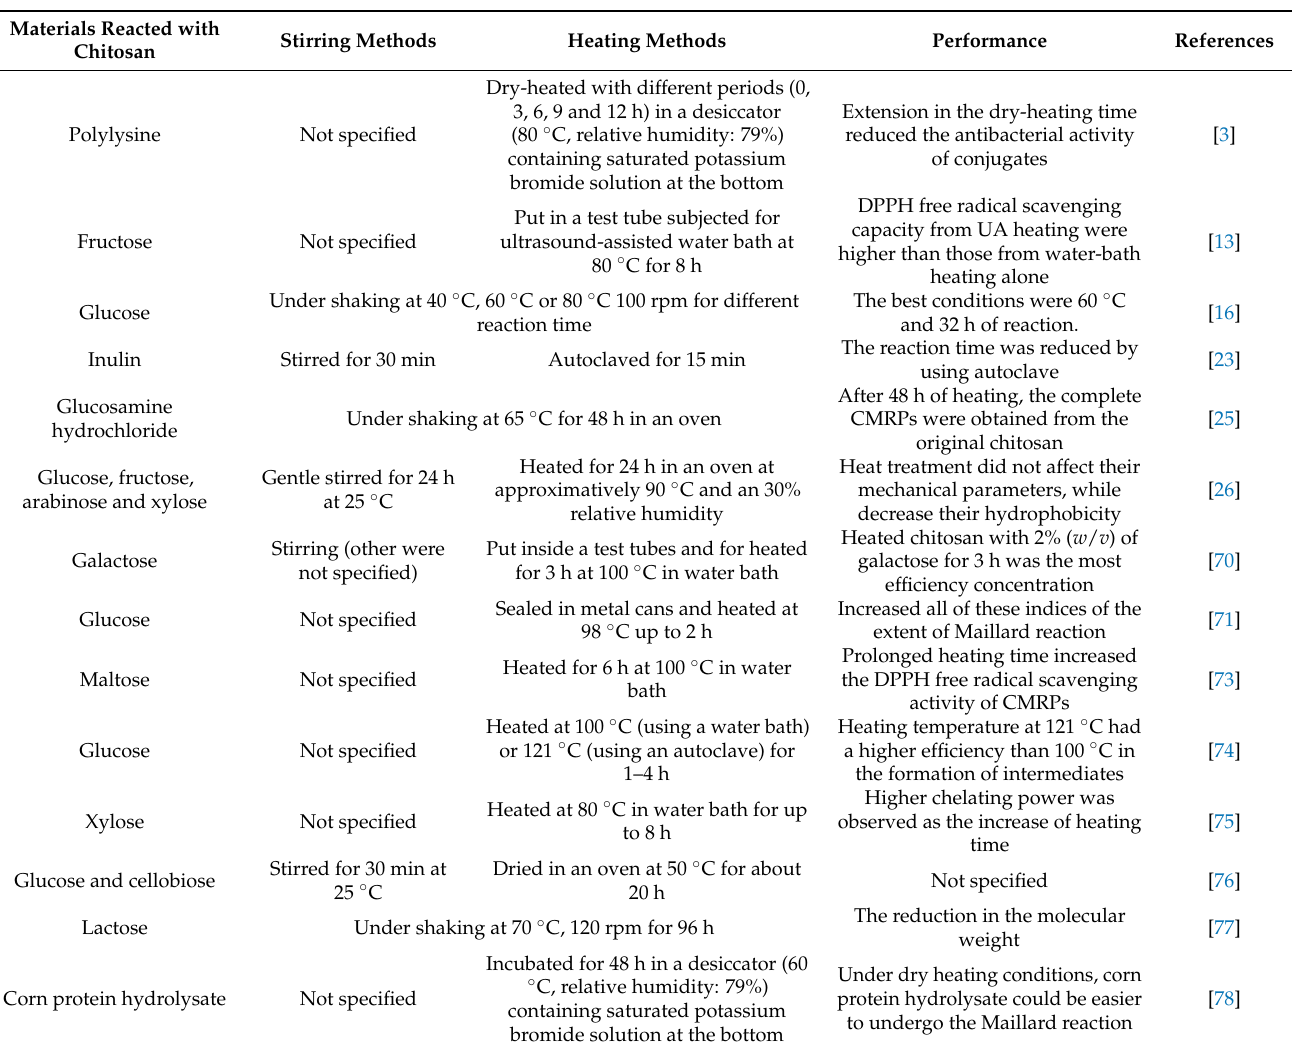
Table 1. An overview of methods for preparing